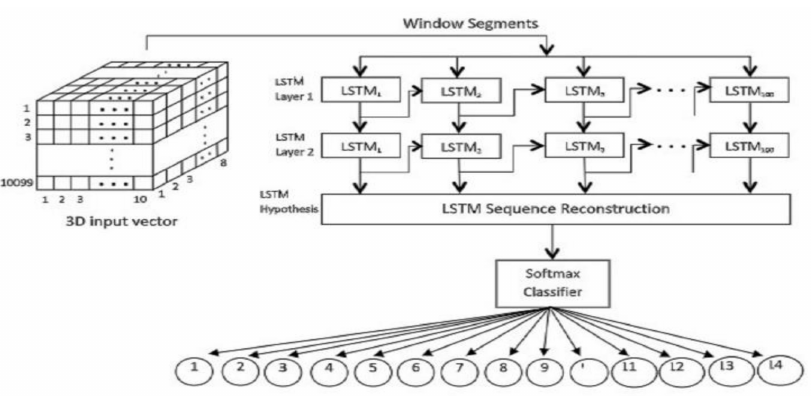
Figure 5. Proposed LSTM